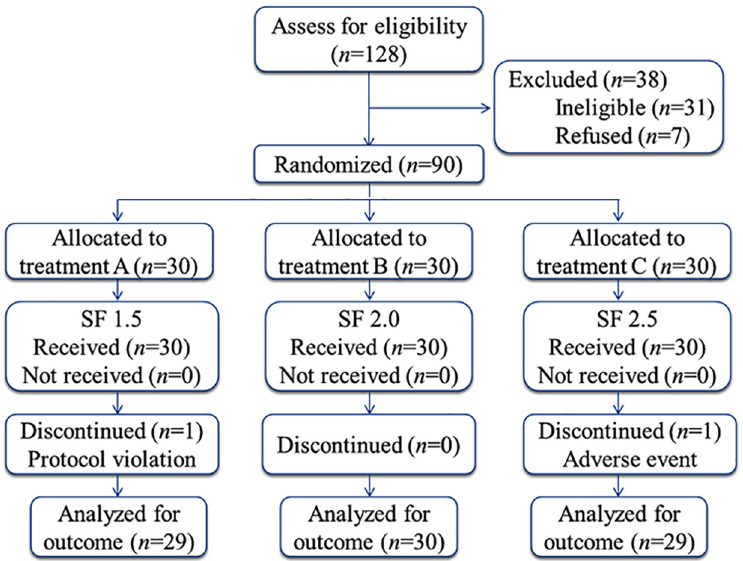
Fig 1. Study CONSORT flow diagram. Patients who were randomly assigned and received the intended treatment were analyzed for the outcomes. Two patients were discontinued: one was discontinued at 38 hours after surgery due to a severe anaphylactic reaction caused by medication treatment in surgical ward, and the other was discontinued at 30 hours after surgery due to violation of the protocol. SF 1.5, 1.5 μ g/kg total dose of sufentanil in the PCA pump. SF 2.0, 2.0 μ g/kg total dose of sufentanil in the pump. SF 2.5, 2.5 μ g/kg total dose of sufentanil in the pump.